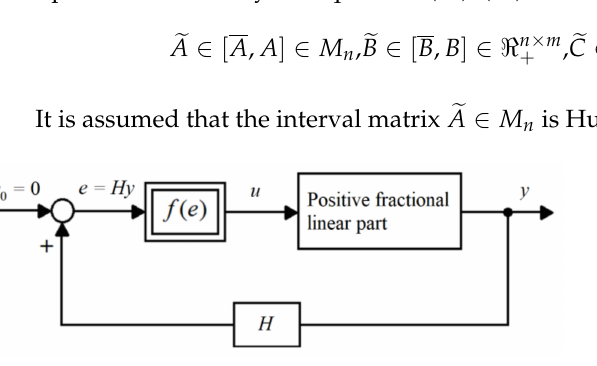
Figure 1. The nonlinear feedback system.